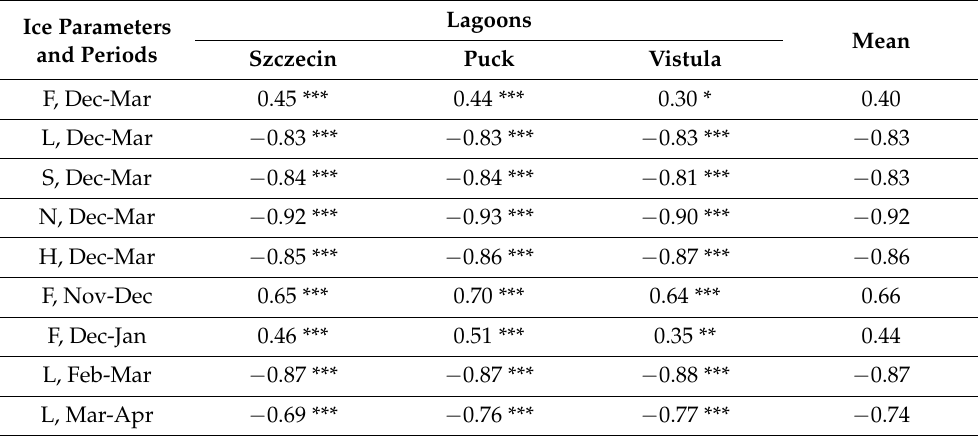
Table 5. Correlation coefficients between the air temperature in individual periods and ice parameters (designations as in Table 2) in southern Baltic coastal lagoons